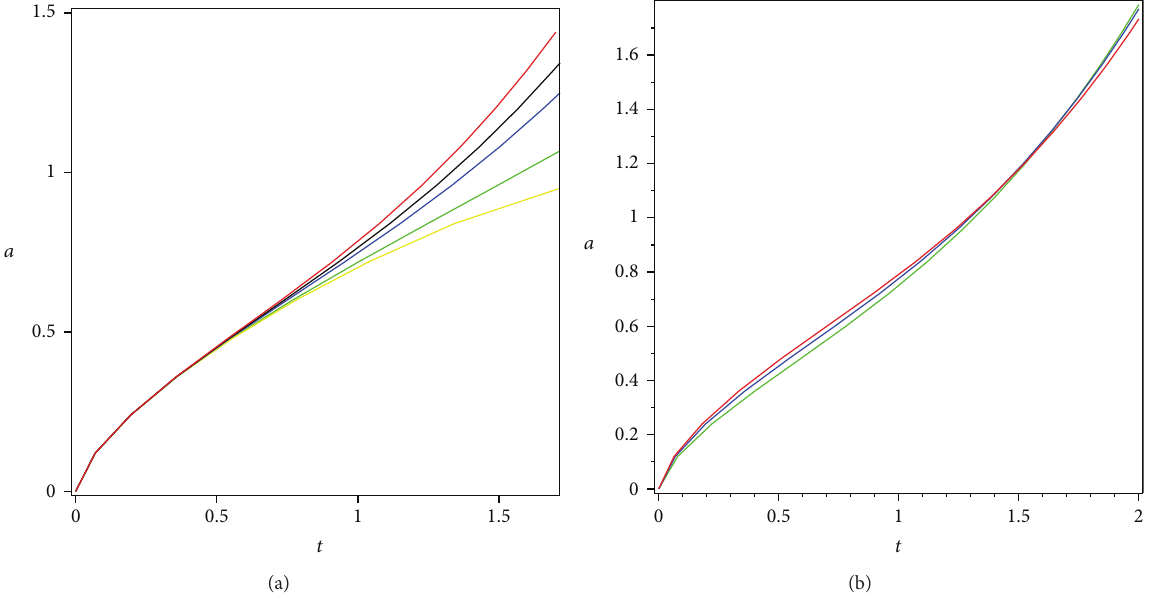
Figure 2: Scale factor versus time for (a) 𝛼 = 0.5 and 𝐴 = 1/3 . 𝐵 = 0 (yellow), 𝐵 = 0.6 (green), 𝐵 = 1.8 (blue), 𝐵 = 2.5 (black), 𝐵 = 3.4 (red). (b) 𝐵 = 3 and 𝐴 = (1 − 𝛼)/(1 + 𝛼) . 𝛼 = 0.1 (green line), 𝛼 = 0.5 (blue line), 𝛼 = 0.9 (red